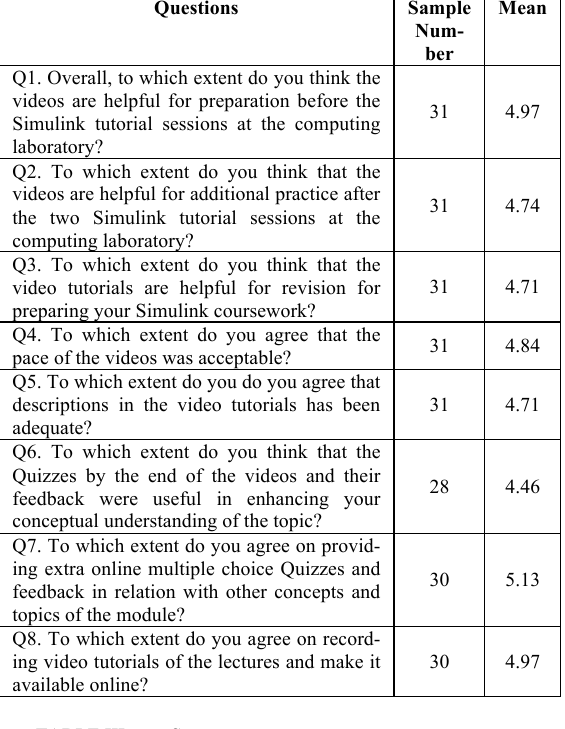
S TUDENTS AVERAGE MEAN RESPONSE TOWARDS PROVIDING A SOFTWARE TOOL SUCH AS THE CSAT FOR INTERACTIVE SIMULATIONS OF CONTROL SYSTEMS TOPICS : FIRST & SECOND ORDER SYSTEMS ; ZEROS , POLES , AND TIME RESPONSES ; FREQUENCY RESPONSE ; AND CONTROLLER